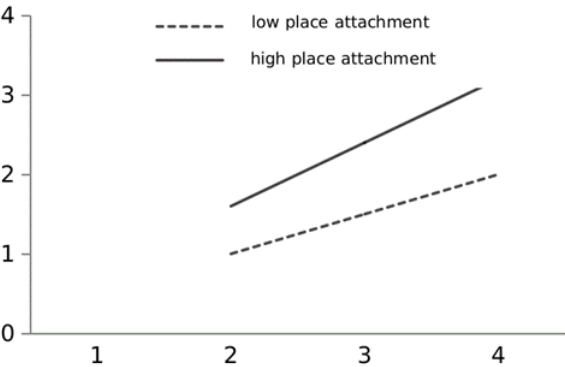
Figure 2. The regulatory role of place attachment on the relationship between residential satisfaction and urban settlement intention. and urban settlement